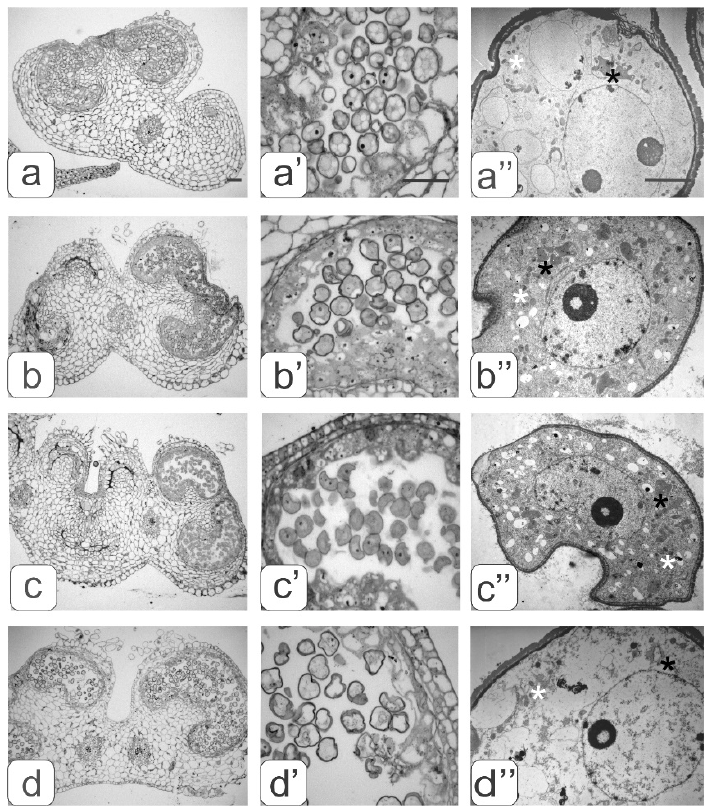
Figure 4. Cross-sections of anthers with various types of developmental abnormalities ( a – d ). Pollen sacs ( a ’– d ’) and microspore ultrastructure ( a’ ’– d” ) from these anthers. black asterisks—plastids, white asterisks—mitochondria. Bar—30 µ m (for semi-thin sections: a–d’) and 3 µ m (for ultrathin sections: